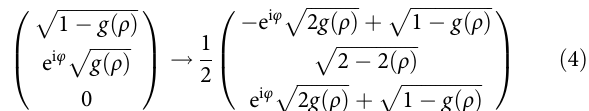
Under a π /2 spinor rotation about the y axis, the spinor transforms as p ffiffiffiffiffiffiffiffiffiffiffiffiffiffiffiffiffi ffiffiffiffiffiffiffiffiffiffiffiffiffiffiffiffiffi p0 1 1 (cid:2) g ð ρ Þ ffiffiffiffiffiffiffiffiffiffiffiffiffiffiffiffiffi p B C @ A ð 4 Þ 2 (cid:2) 2 ð ρ Þ ffiffiffiffiffiffiffiffiffiffiffi p ffiffiffiffiffiffiffiffiffiffiffiffiffiffiffiffiffi þ e i φ 2 g ð ρ Þ 1 (cid:2) g ð ρ Þ Þ approximates the vortex-core pro fi le where g ð ρ Þ ¼ ρ 2 = ð ρ 2 þ r 2 0 with size parameterized by r 0 . The transformation de fi ned by Eq. (4) is illustrated in Figs. 2c, d and 3a – c. After the rotation, a